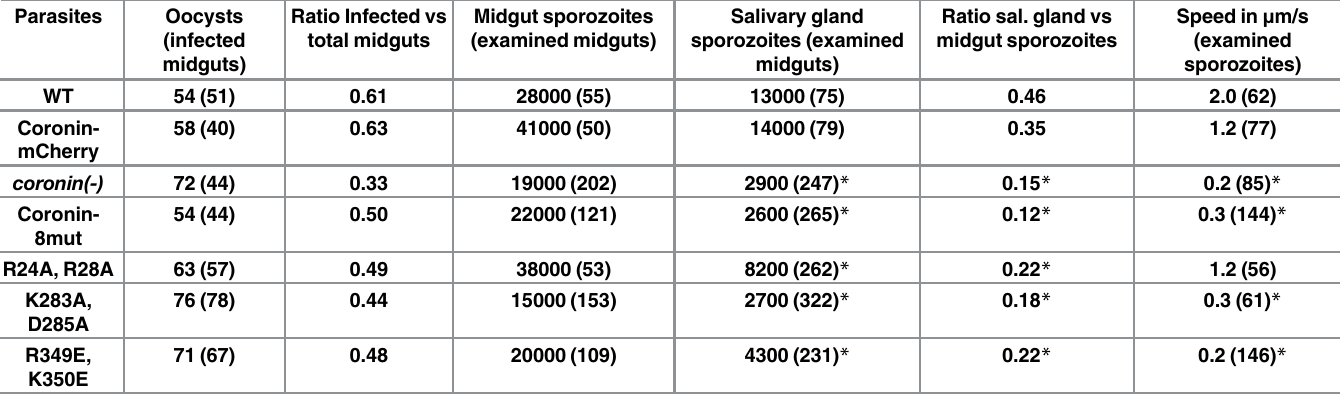
Table 1. Comparison of the different parasite strains in the infectivity of mosquitoes and the in vitro speed of salivary gland sporozoites. Signifi- cant differences are indicated with an asterisk. Note that sporozoites from the R24A, R28A mutant, despite lower numbers in the salivary gland moved with comparable speed to the coronin-mCherry parasites. Note that coronin-mCherry parasites are significantly slower than WT